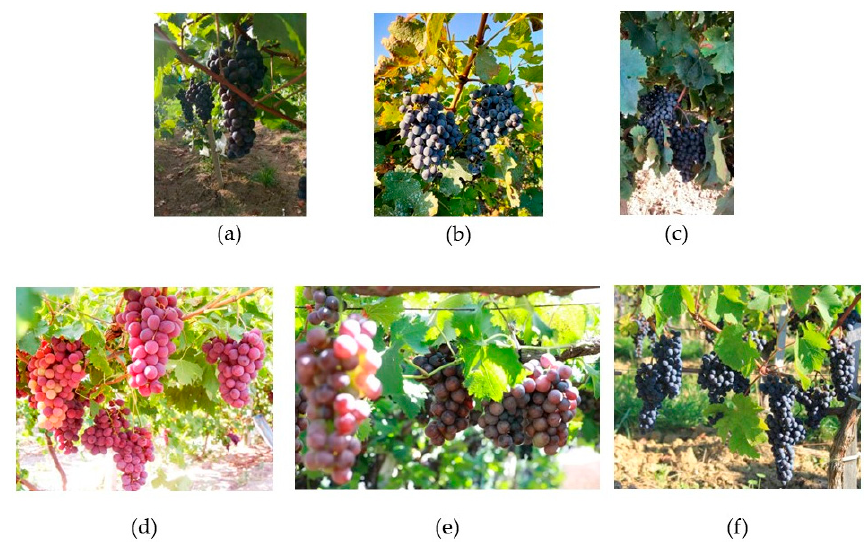
Figure 4. Diversity of shooting angles and light: ( a ) Flat angle; ( b ) Elevation angle; ( c ) Depression angle; ( d ) Sidelight; ( e ) Backlight; ( f ) Front light.